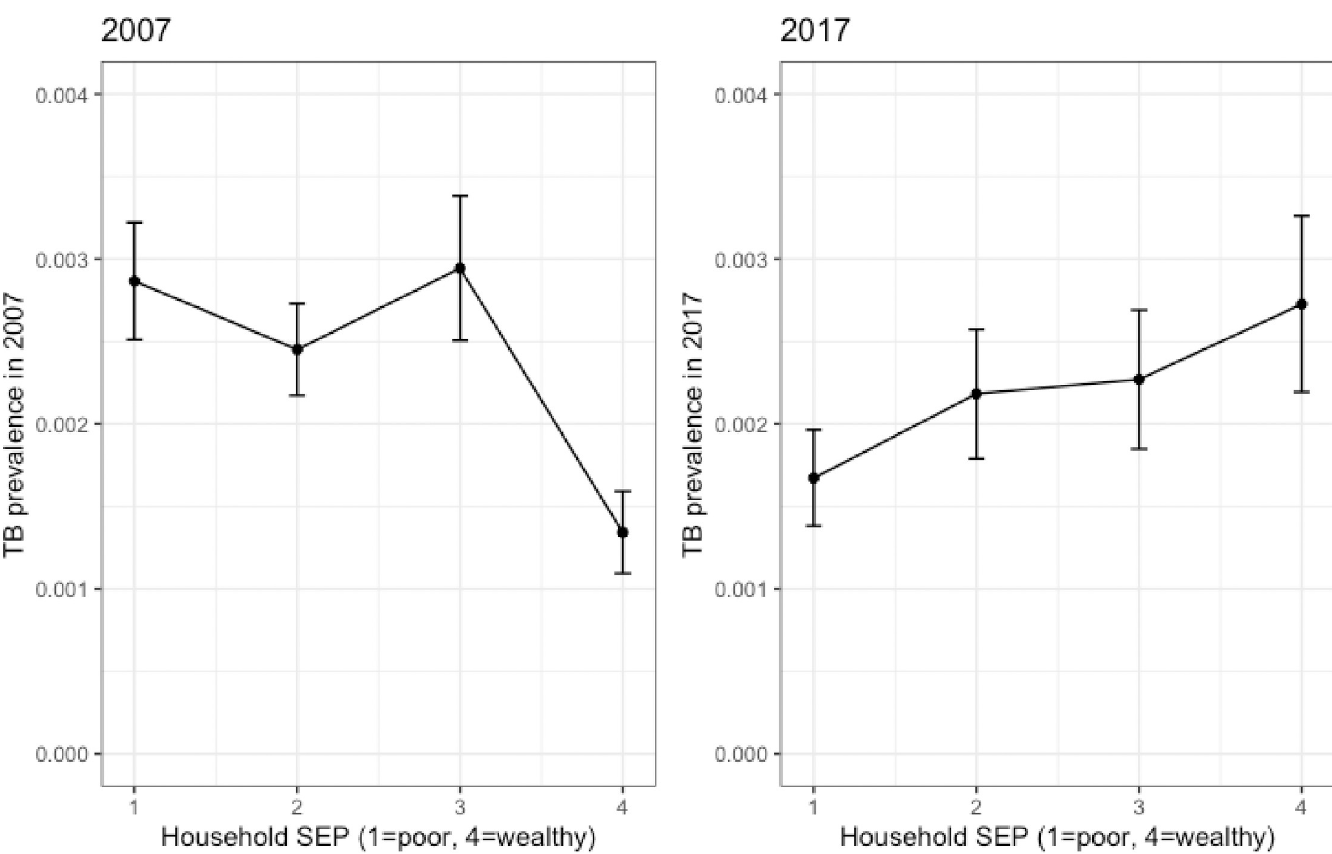
Fig 2. The distribution of tuberculosis (TB) prevalence by socioeconomic position (SEP) as measured in the 2007 and 2017 tuberculosis prevalence surveys. The plot shows the average household asset index AU : InthelegendtoFig 2 : IchangedSEPindextoassetindextomatchtheterminologyusedelsewhereinthepaper ð assumingtheyreferredtothesameindex Þ : Ifthisisnotcorrect ; pleaseeditasnecessary : and the confidence intervals around the mean.